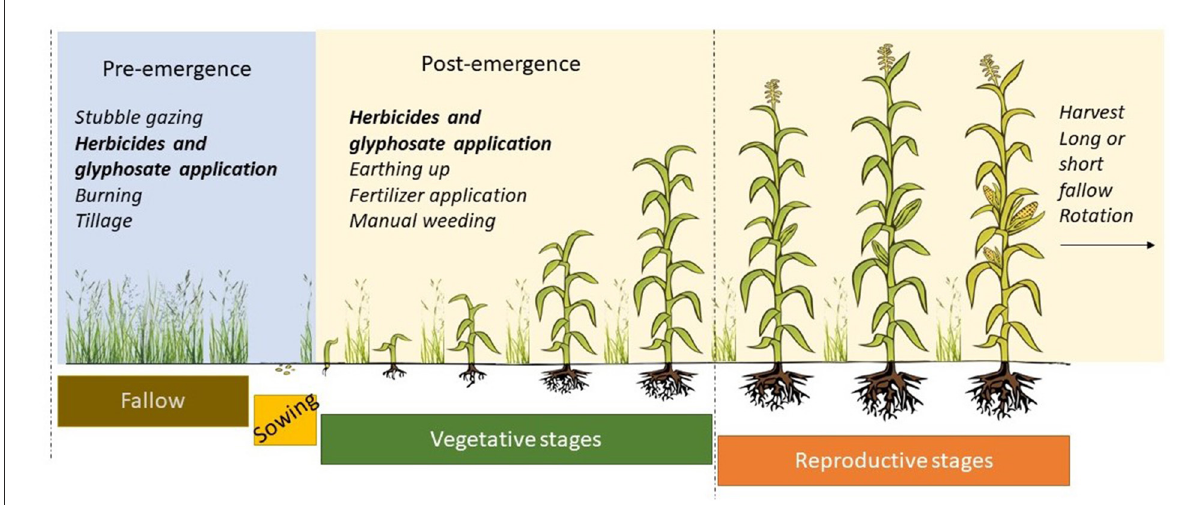
FIGURE3 Main management practices in each stage of the maize productive cycle and moments of herbicide and glyphosate application. Not all the practices are performed in all the plots.